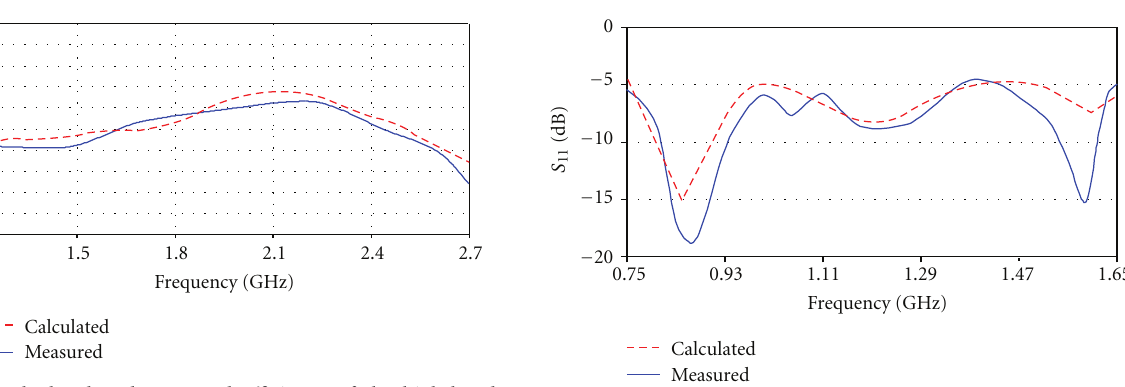
Figure 7: Calculated and measured return loss of the low-band antenna of the third dual antenna configuration.